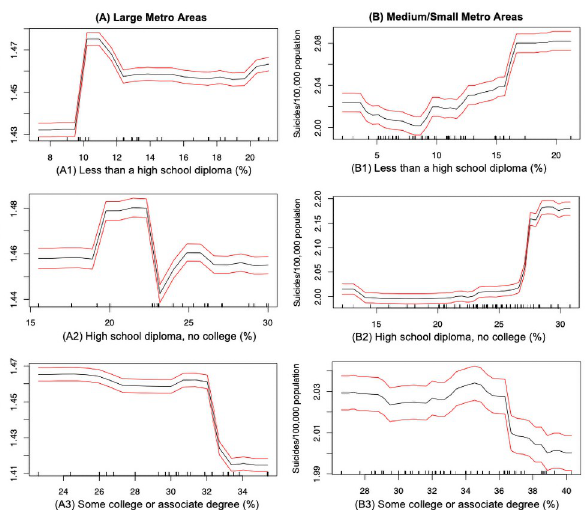
Fig 9. Suicide mortality rate and education: (A) Large metro areas; (B) Medium/small metro areas. Rug lines on the x axis indicate prevalence of data points; black curve is the average marginal effect of the predictor variable; red lines indicate the 95% confidence